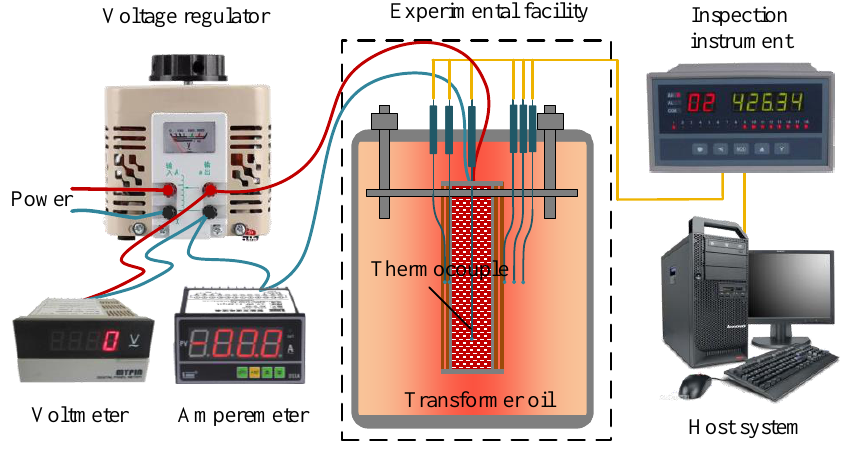
Figure 5. The schematic diagram of the experimental platform. Turn on the single-phase voltage regulator to output a specific stable power to heat the copper tube. When the values of the thermocouple change by less than 0.2 K over half an hour, heat generation and transfer have reached dynamic equilibrium. The computer records two sets of temperature data every minute, and each test records 100 sets of data. After one experiment, wait for the device to cool to ambient temperature and then carry out another